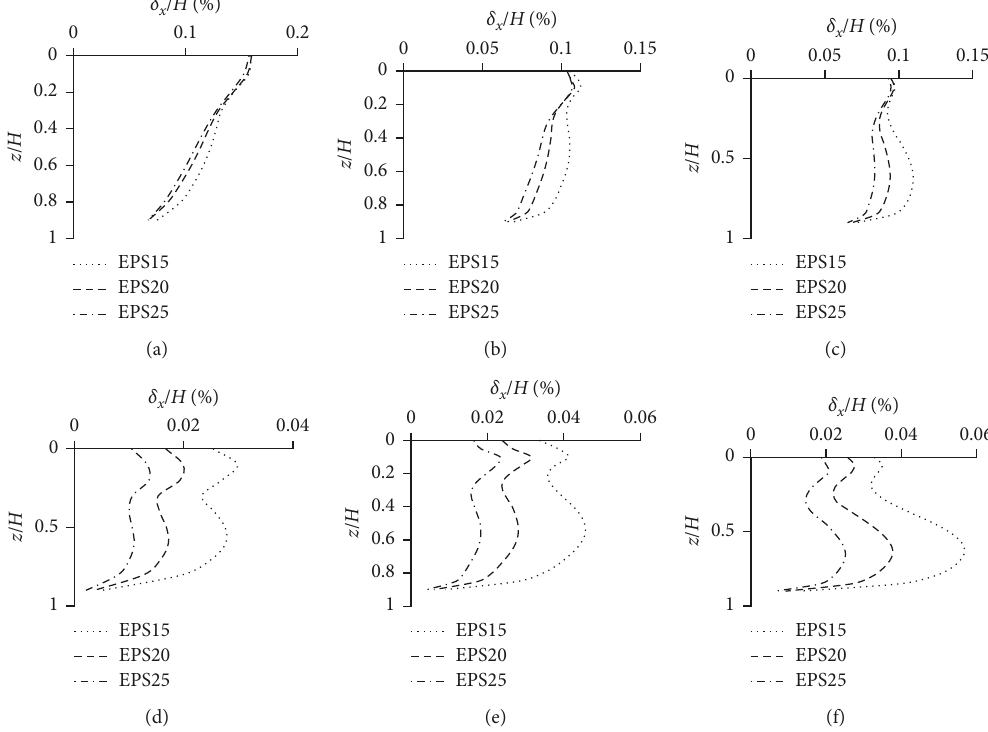
Figure 6: Influence of geofoam density with the relative thickness of 0.05H on the lateral displacements of soil: (a, b, and c) yielding retaining walls and (d, e, and f) nonyielding retaining walls. (a) H